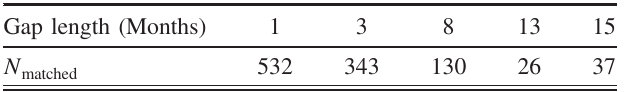
TABLE I. Approximate length, in months, of the gap in time between taking the FMCE post-test in PHYS I and the FMCE pre-test in PHYS II, along with the number of students in the dataset with that gap